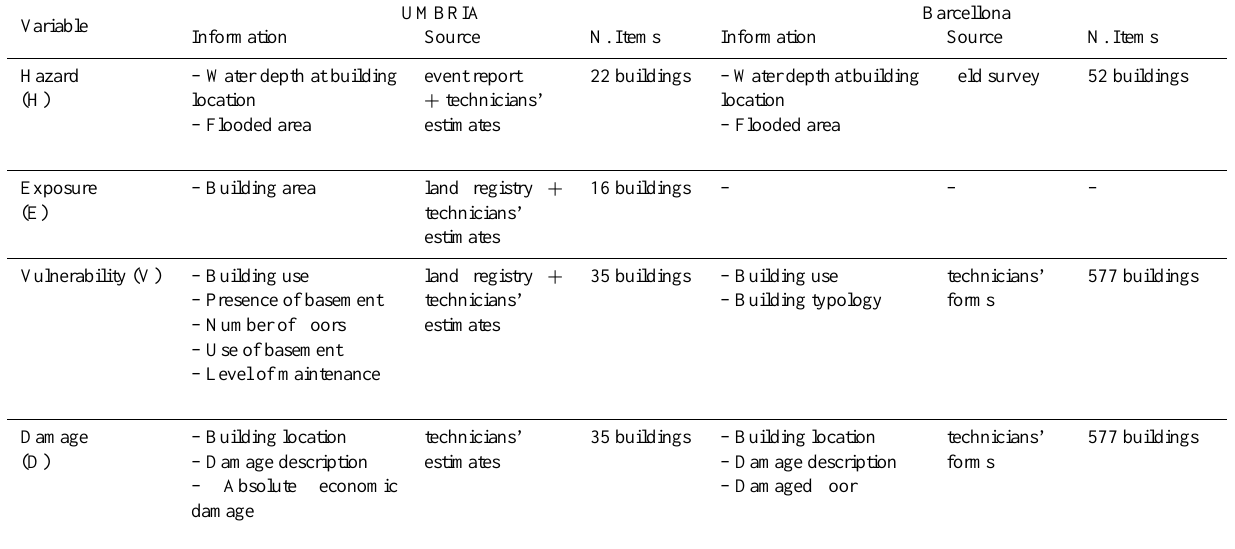
Table 1. Hazard (H), exposure (E), vulnerability (V) and damage (D) information, collected in the Umbria and Barcellona case study. The table shows that information on the water depth and building surface is the most critical, as its lacking reduces the sample size. Present shortcomings derive from the fact that water depth and building area are not compulsorily requested in damage forms/technicians’ estimates; on the other hand, building areas cannot be derived from the land registry, as it does not cover the entire national territory.